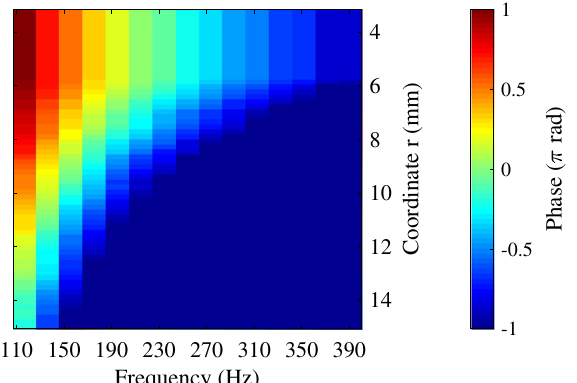
Figure 10. Example of a phase spectrum calculated over the line of analysis for the illustrative case in the plane B.